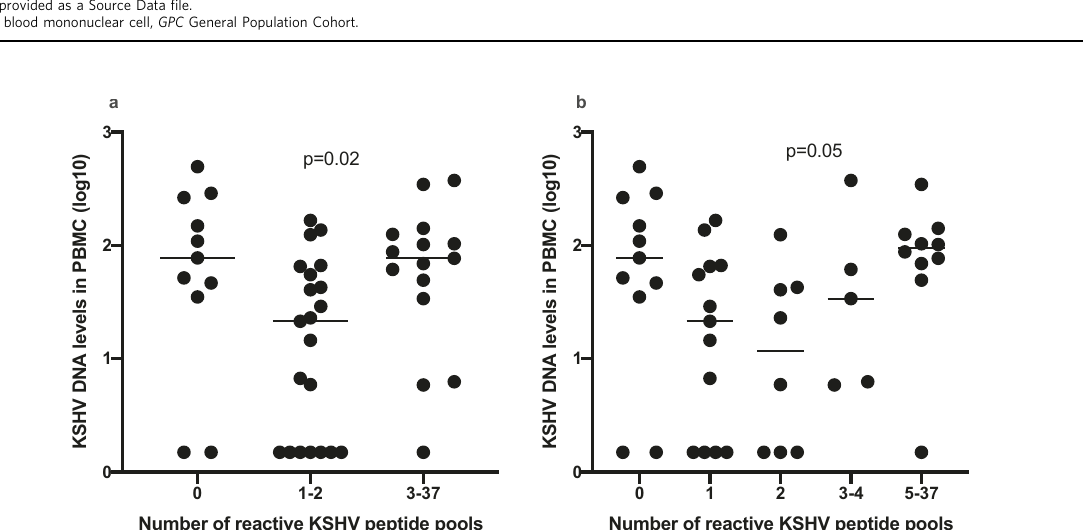
Fig. 6 KSHV DNA levels in peripheral blood mononuclear cells (PBMC) by number of reactive peptide pools. ( a ) individuals grouped in 3 categories; ( b ) individuals grouped in 5 categories.